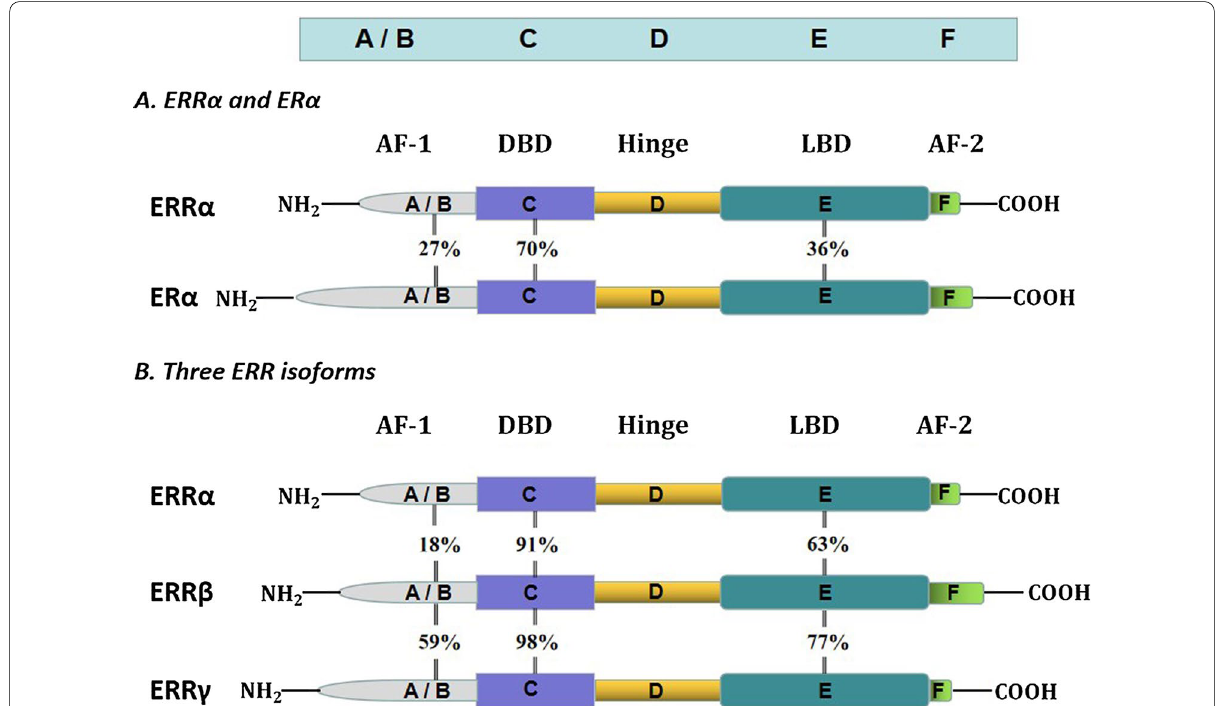
Fig. 1 Structure of estrogen receptor α and the three estrogen-related receptors. ERRs are composed of six conserved regions (A/B, C, D, and E/F domains), and the colors symbolize the diverse functions of these domains. The number between the two receptors represents the sequence identity of the same domain in the different